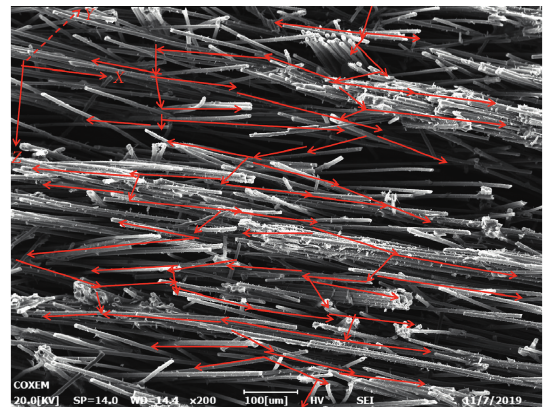
Figure 6: Heat transfer model in the carbon/carbon fiber composite.